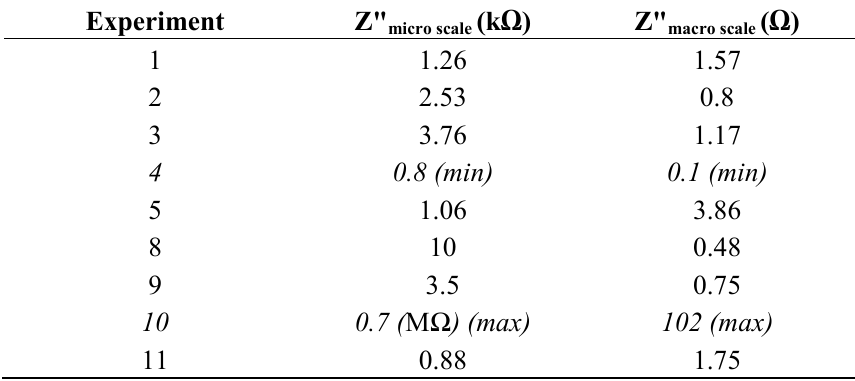
Table 4. Imaginary impedance values (Z") measured at the peak area of each spectrum (Figure 7) after the first potentiodynamic